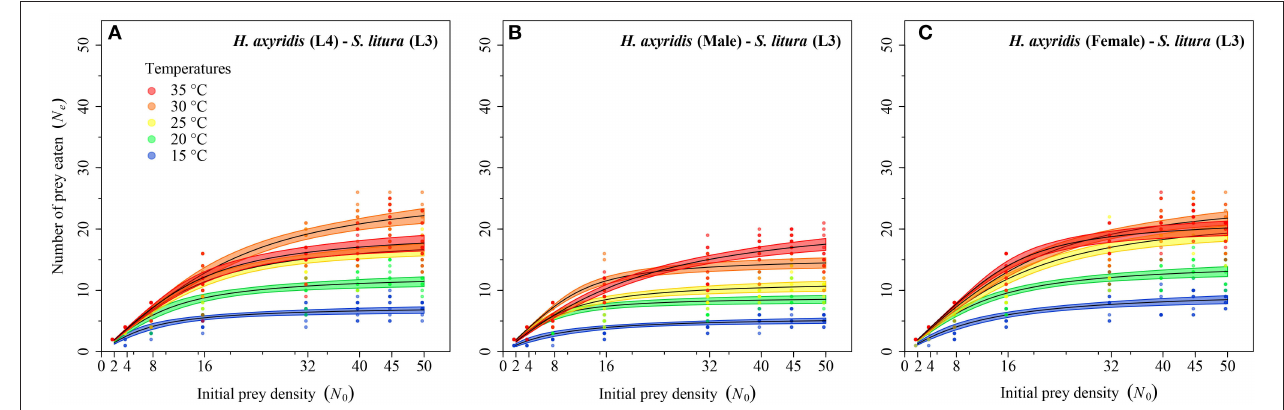
FIGURE 5 | Functional response of different stages of Harmonia axyridis [L4, Female (A–C) ] foraging on 3rd instar Spodoptera litura . Dots represent the observed numbers of prey consumed at each initial prey density, and black lines were predicted by the Roger’s random predator equation, while the shaded areas represent the limits of the 95% confidence intervals. Number of replications (N) =